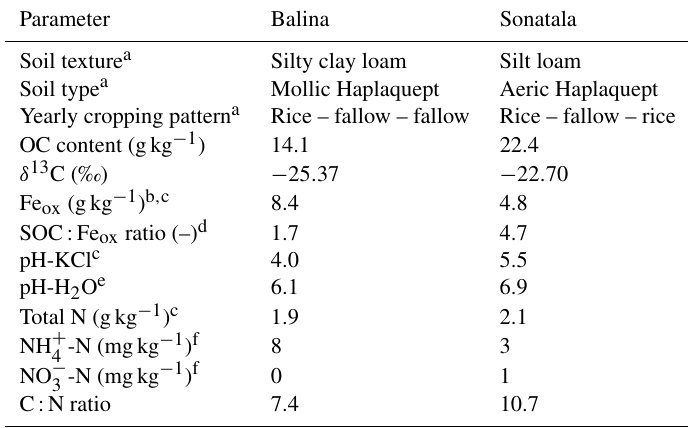
Table 1. Initial properties of the selected two paddy soil series and maize shoots used in the soil incubation experiment. Parameter